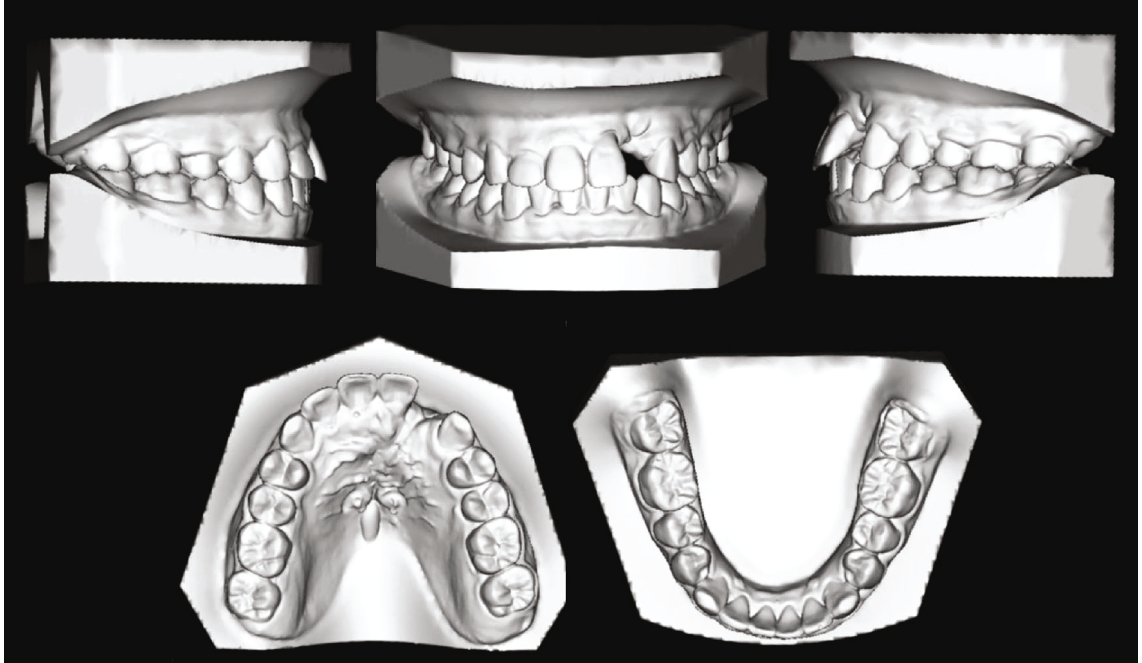
Figure 11: Final stone